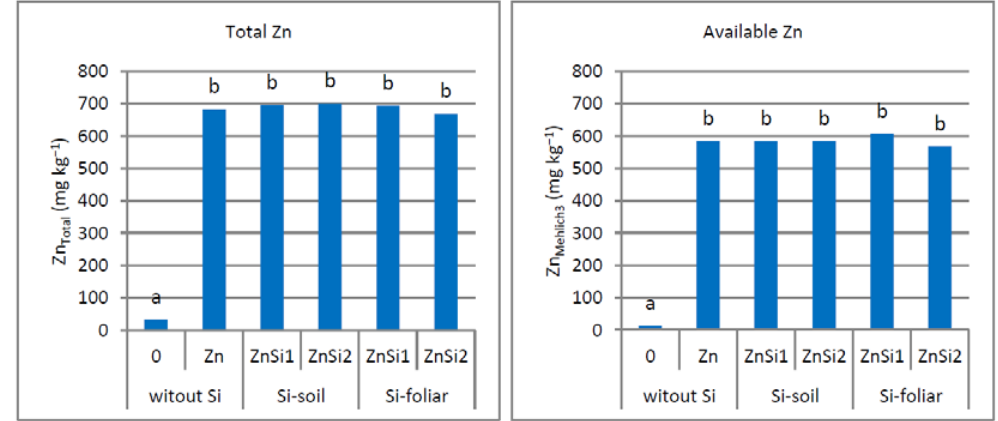
Figure 4. Zn concentration in soil. Values marked with the same letters indicate no significant difference according to Tukey ’ s test ( p < 0.05).